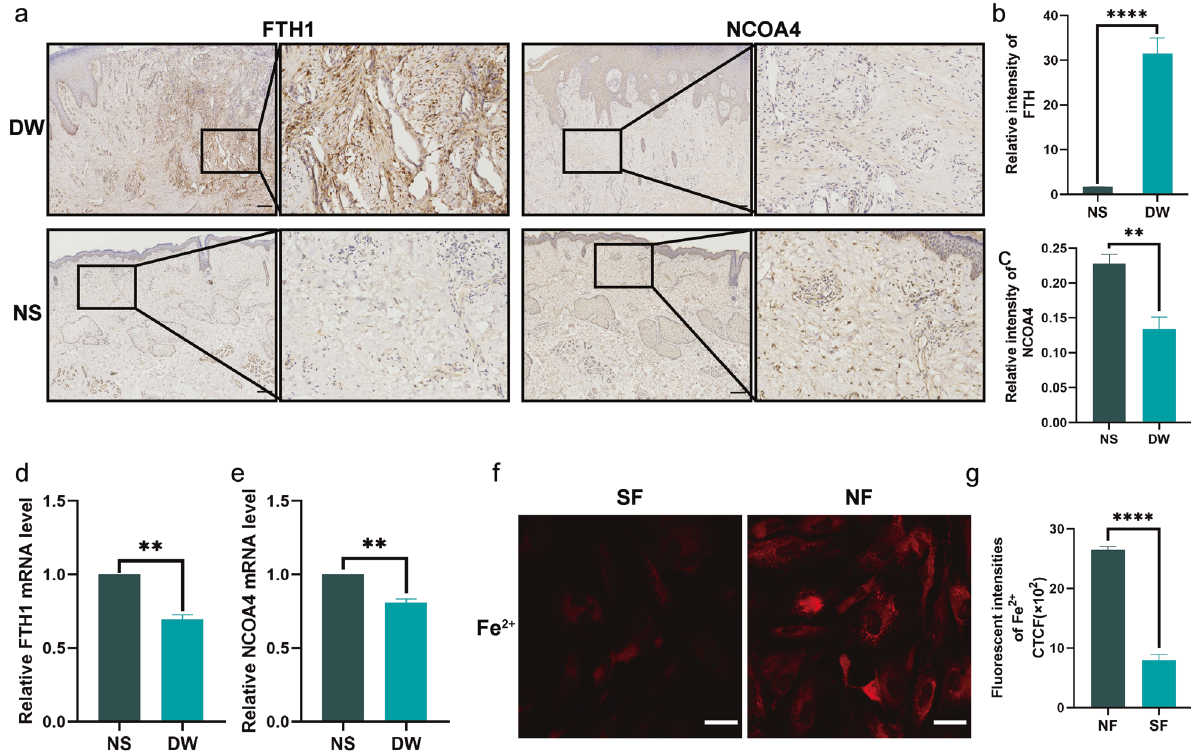
Fig. 3 Diabetes wounds exhibit impaired ferritin degradation. a Immunohistochemistry staining of FTH1 and NCOA4 in DW and NS. Scale bar = 200 mm. b , c Quanti fi cation of FTH1 and NCOA4 immunostaining in a . d , e The mRNA level of FTH1 and NCOA4 were detected by real- time PCR in DW and NS. f Intracellular free iron ions in fi broblasts. Scale bar = 50 μ m. g Quanti fi cation of intracellular free iron ions in f . Data represent the mean ± SEM of triplicates. ** P < 0.01; **** P < 0.0001. DW diabetes wounds, NS normal skin, NF normal fi broblast, SF senescent fi broblast, CTCF corrected total cell fl